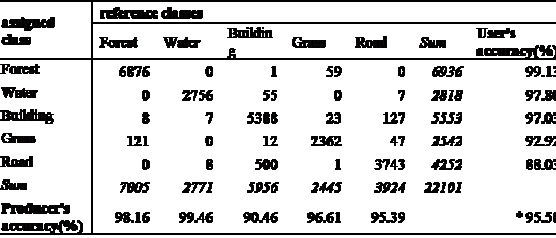
Figure 3. ALOS satellite imagery and the area used in this study.